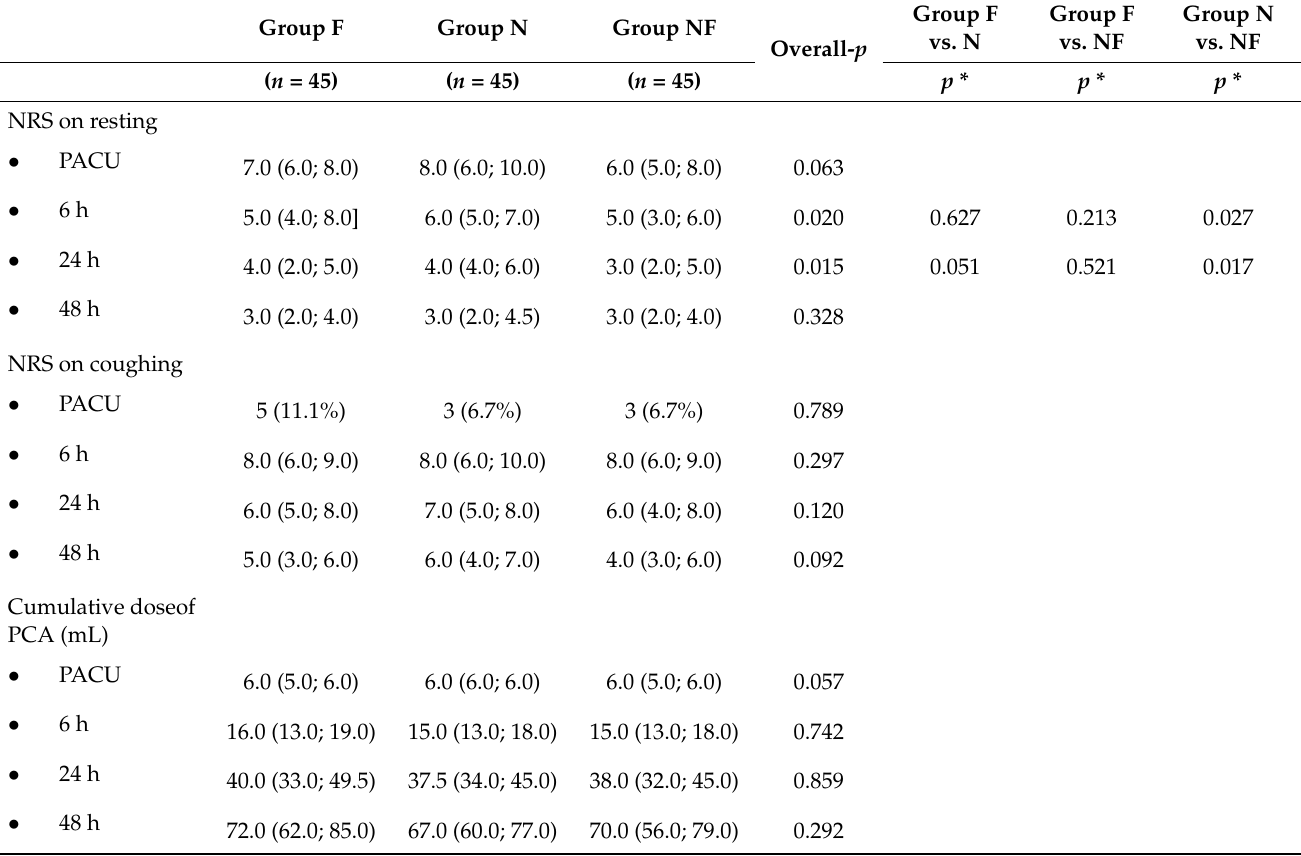
Table 2. Change in numerical rating scale (NSR) scores in the three groups over time and the dose of patient-controlled analgesia.